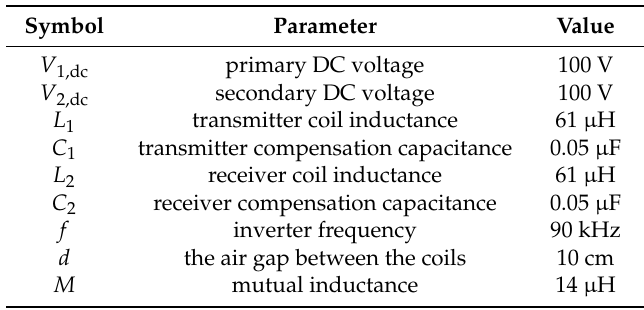
Table 1. Key parameters of the proposed